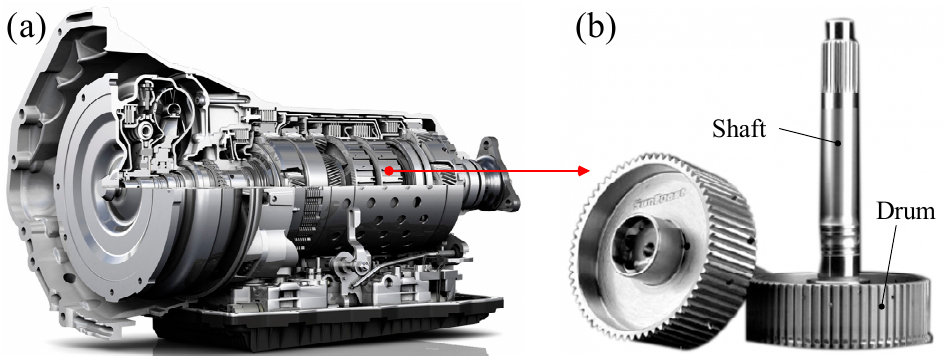
Figure 1. Automotive transmission and clutch drum. ( a ) Auto transmission; ( b ) clutch drum.